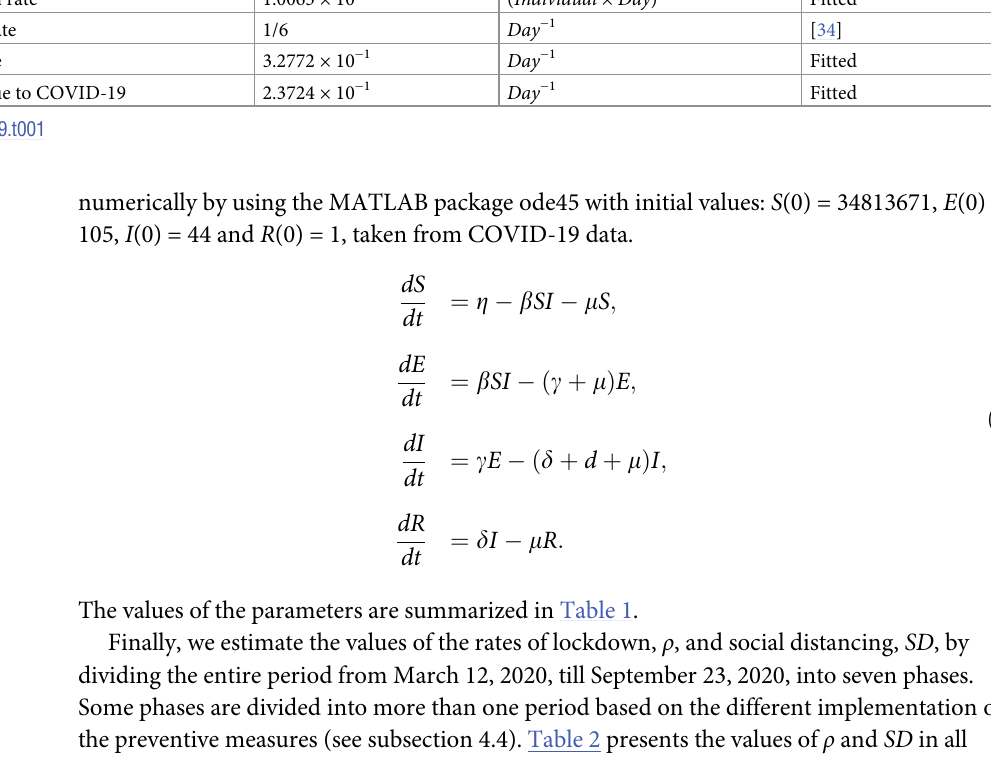
Table 2. Estimated values for ρ and SD in model (1) with corresponding values of R